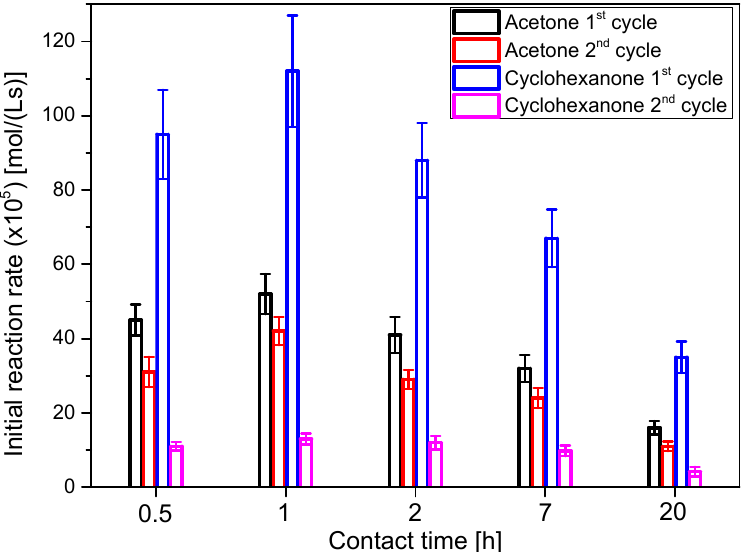
Figure 5. Initial reaction rate for runs with catalysts activated at several contact time with HCl 3 N. Acetone-glycerol ketalization was performed at 25 °C, acetone/glycerol molar ratio of 6 and using 50 g/L of the catalyst being tested. Conditions for cyclohexanone/glycerol ketalization were 40 °C, the same molar ratio of cyclohexanone to glycerol and identical catalyst concentration as in the runs with acetone. The catalyst used for the first cycle was recovered, washed with acetone and dried at 100 °C for 24 h before using it for the second cycle.